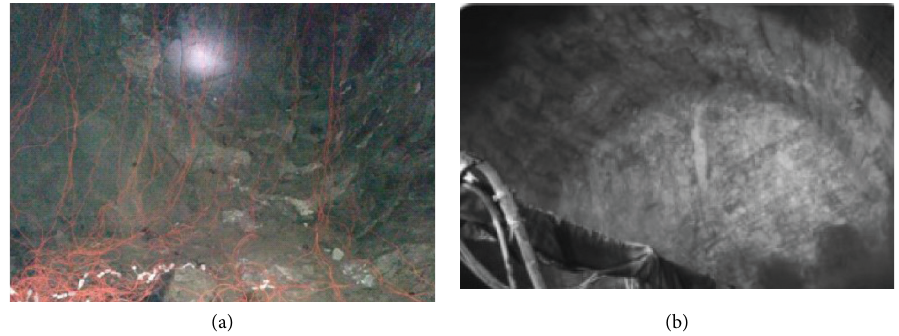
Figure 17: Application of ECHBT in (a) broken stratum and (b) horizontal thin stratum [57, 69].